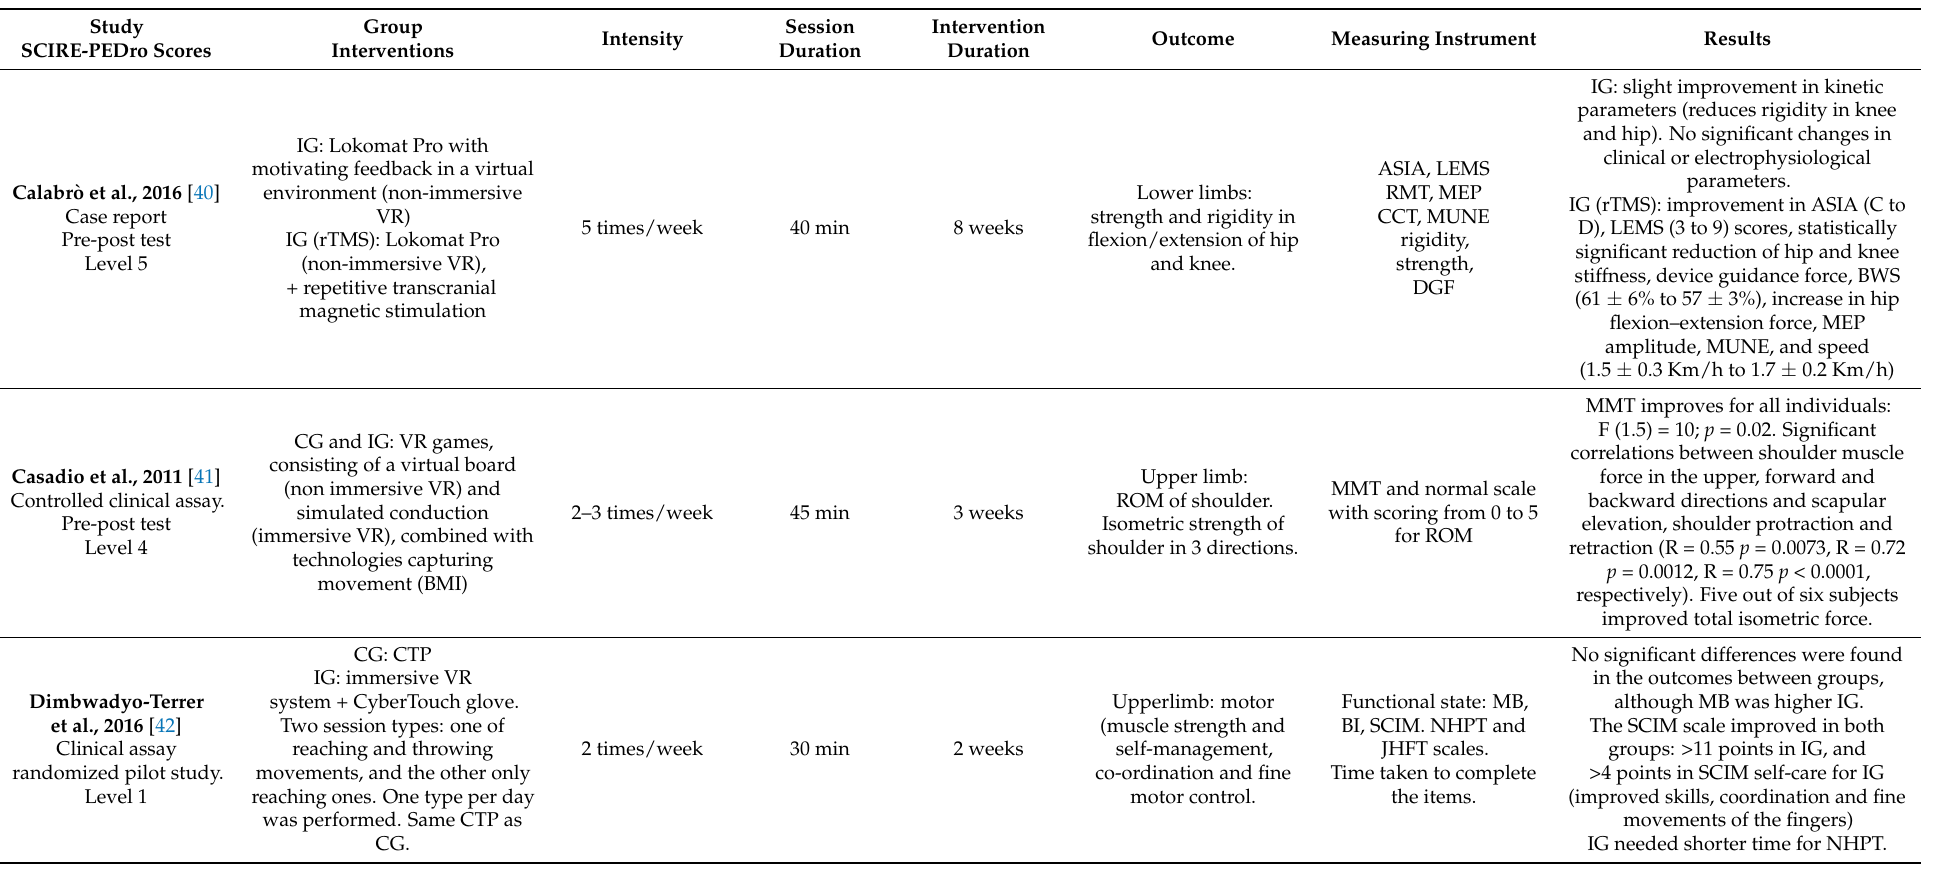
Table 2. Main characteristics of the studies included in the systematic review.